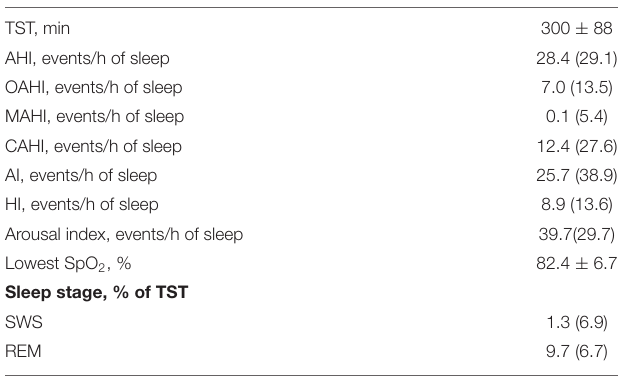
TABLE 2 | Findings of the diagnostic polysomnography.